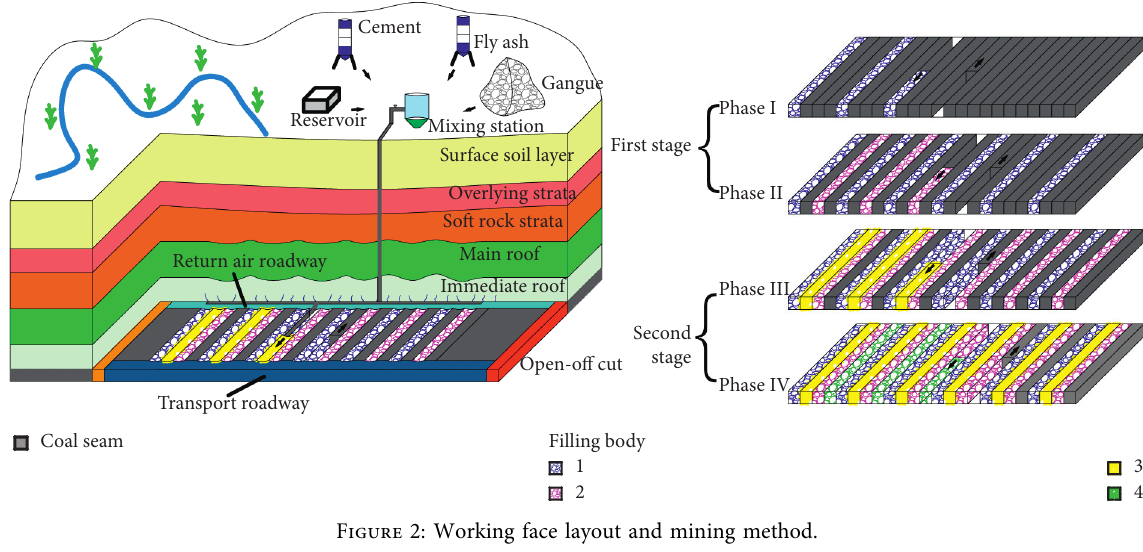
Figure 2: Working face layout and mining method.